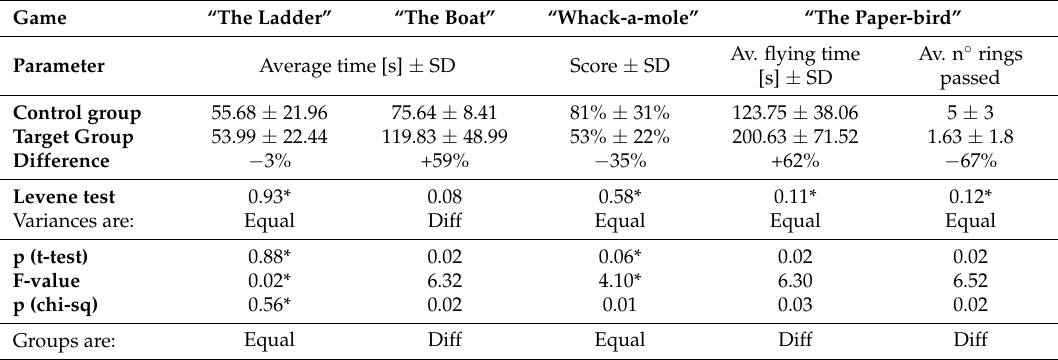
Table 2. Numerical results and statistical analysis per game (Student t-test, one-way Anova and Kruskal-Wallis test (chi-square)). The critical values obtained for p = 0.05 from the t-table and the F-table are respectively t c = 1.76 and F c = 4.6 respectively. *Null-hypothesis not rejected. Grey values are not significant for the data set tested and are only added for completeness.